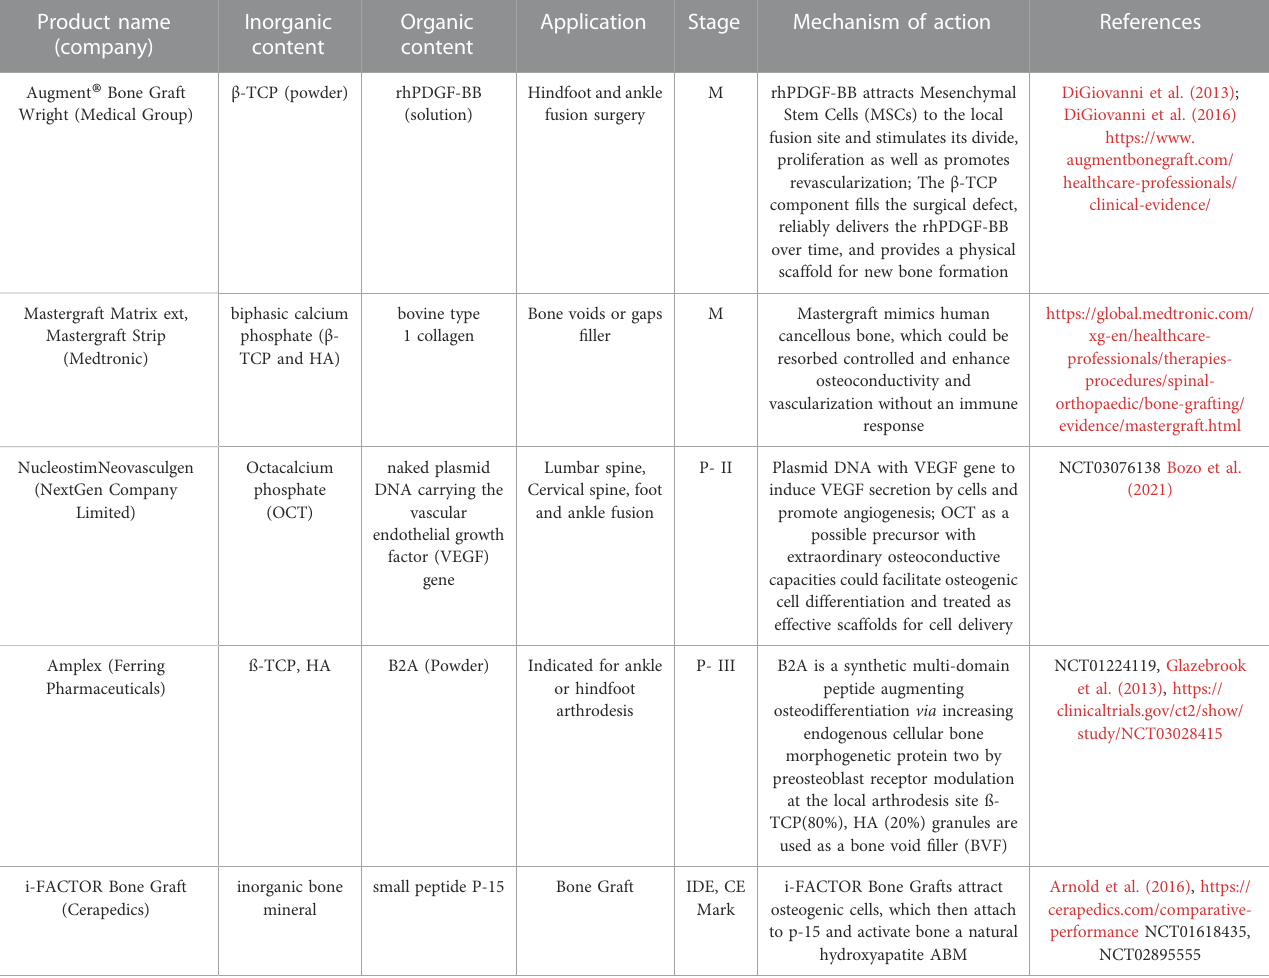
TABLE 4 List of commercial products with organic bioactive molecules (growth factors, peptides or small molecules) and inorganic or hybrid material carrier and their stage of development in the bone scaffolds. Product name